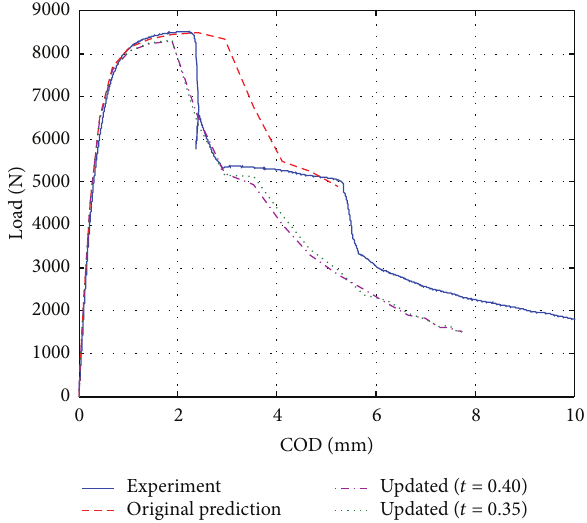
Figure 8: S5 load versus COD profiles from experiment and simulations with varying stress triaxiality thresholds, 𝑡